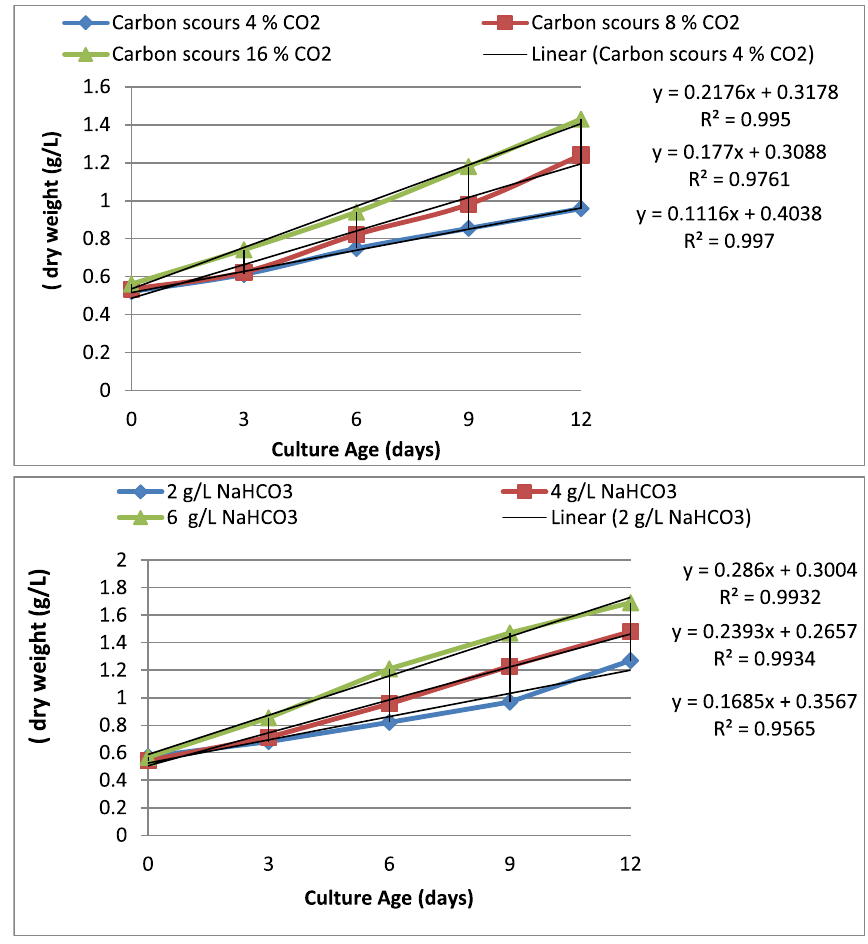
Fig. 1 Impact of carbon source and concentrations on Pseudochlorella pringsheimii growth and and oil